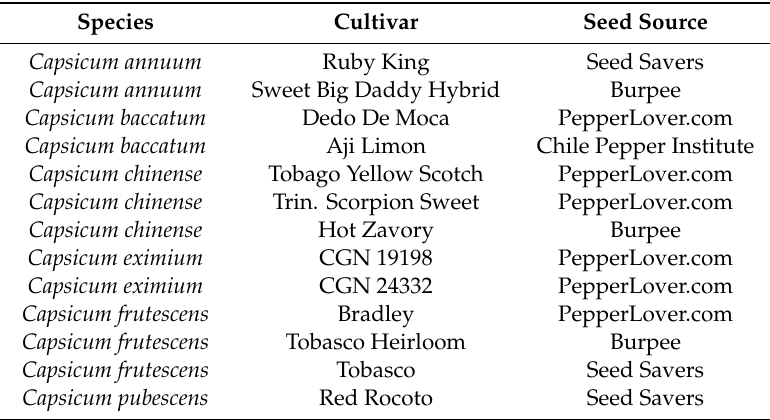
Table 1. Species, cultivar and seed source for cultivars tested in this study.